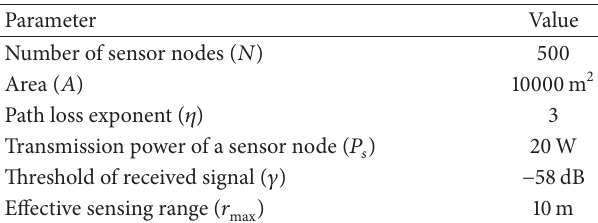
Table 2: Simulation